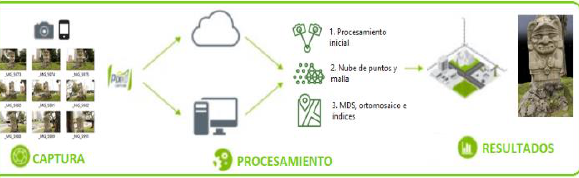
Figure 2. Sculpture San Agustín No.28 workflow.